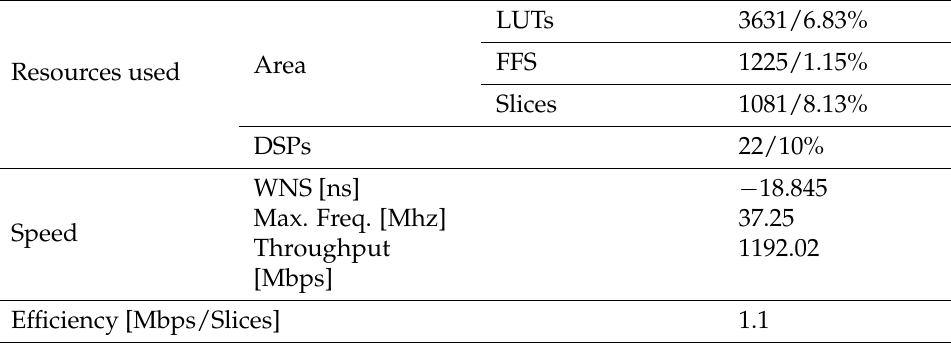
Table 4. Hardware metrics of the proposed SCbSC.